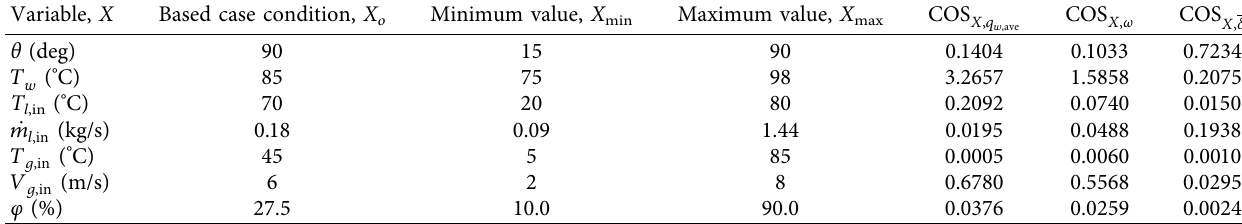
Table 5: Parameter influence